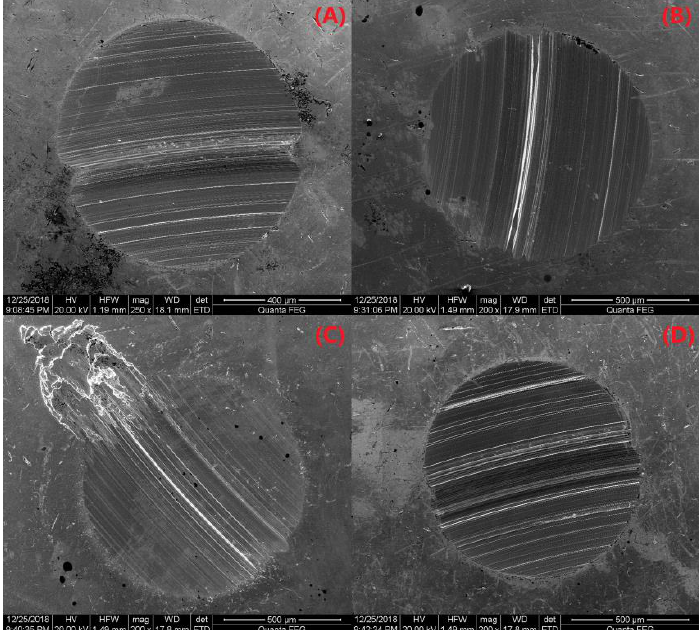
Figure 13. SEM images of the lower ball of ( A ) PAO, ( B ) PAO-PS/P-MMT, ( C ) PAO-PS/P-SLS-MMT, 449 and ( D ) PAO-PS/P-KH570-MMT. 450